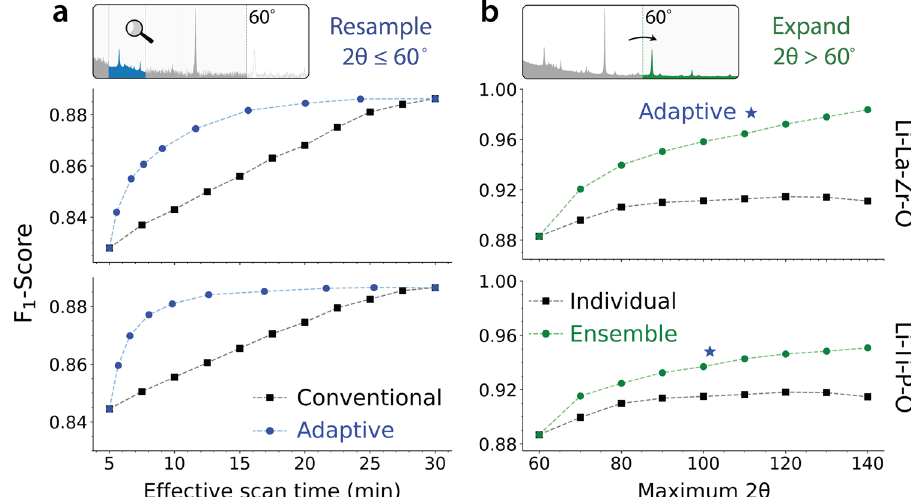
Fig. 2 F 1 -scores achieved by XRD-AutoAnalyzer when applied to simulated patterns in the (top) Li-La-Zr-O and (bottom) Li-Ti-P-O spaces. a Conventional results (black squares) were obtained on patterns with incrementally improved resolution over 2 θ = [10°, 60°], whereas adaptive results (blue circles) were found by resampling a subset of 2 θ ⊆ [10°, 60°] with high resolution. b Individual results (black squares) were calculated by analyzing patterns with distinct maxima (2 θ max ), which were aggregated in a con fi dence-weighted sum to form the ensemble predictions (green circles). Adaptive results (blue star) were obtained by halting expansion of 2 θ max when the prediction con fi dence exceeded